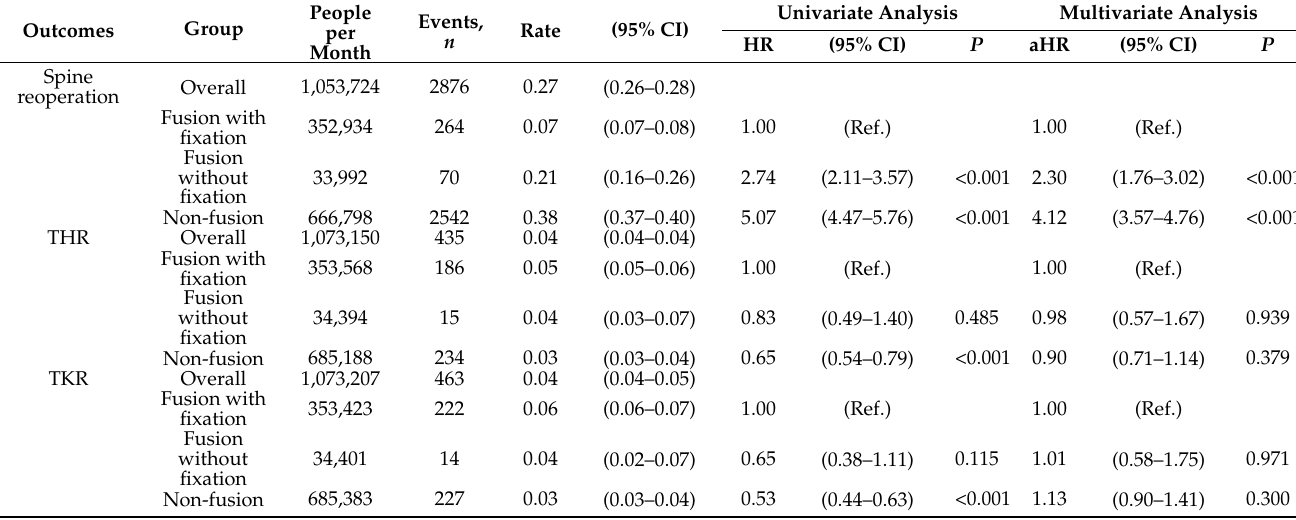
Table 2. The incidence (per 100 people/month) of spine reoperation and joint replacement surgeries after short-segment spinal discectomy surgeries for degenerative disc disease. Outcomes